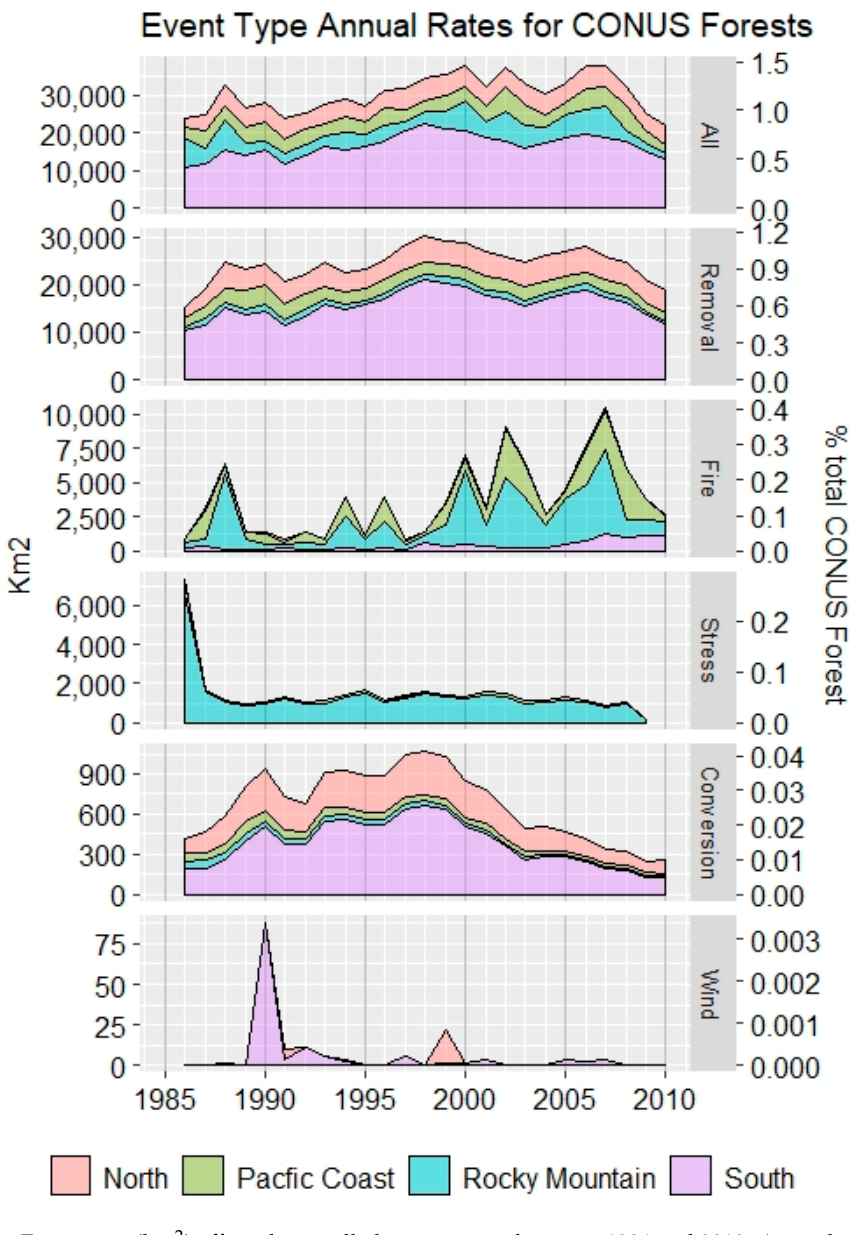
Figure 2. Forest area (km 2 ) affected annually by event type between 1986 and 2010. Annual rates are stacked and color filled by FIA region. Note that the scale of the y -axis varies per event type. A second y -axis on the right labels the area as a percentage of total CONUS forestland.